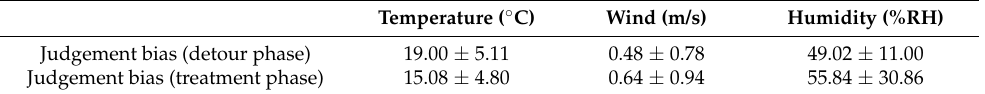
Table 3. Standard means and deviations for weather variables during the experimental